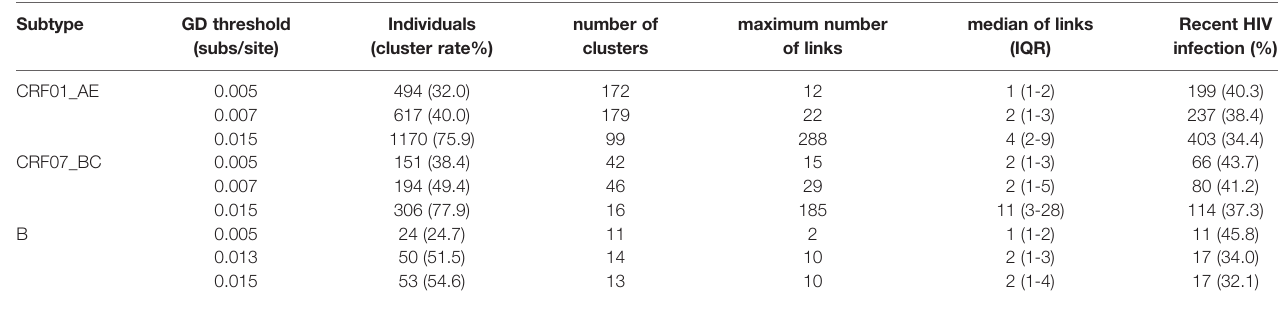
TABLE 2 | Network parameters with different thresholds for the three main epidemic subtypes in Shenyang.